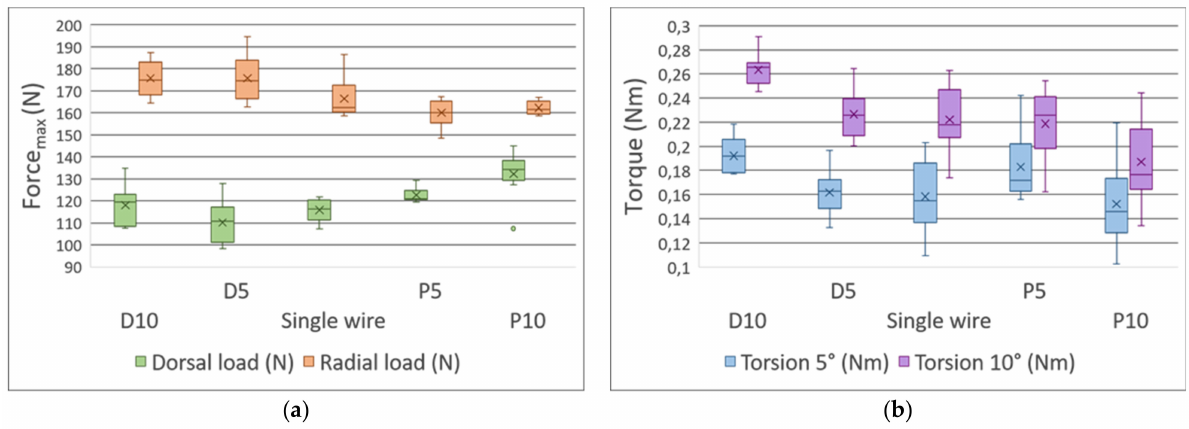
Figure 9. Box plots of the ( a ) three-point bending and ( b ) torsion tests representative of Group III and Group III subgroups. The radial, dorsal loads, and the 5 ◦ and 10 ◦ torsions are coded using various